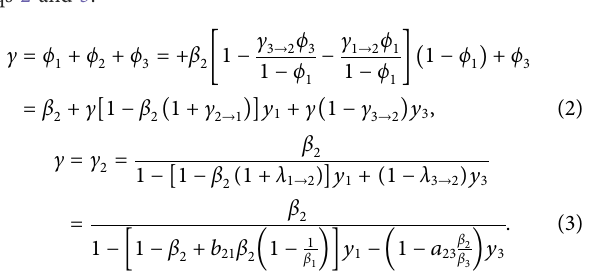
FIGURE 1 System for the packing of multiple particles.